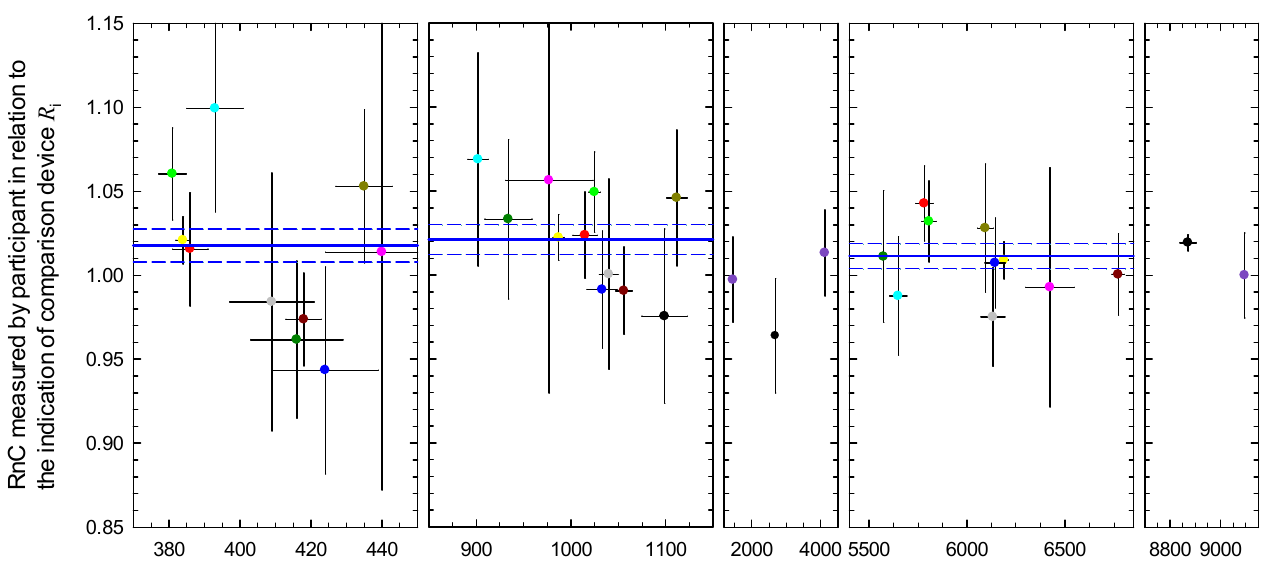
Figure 1. Ratio 𝑅 (cid:3036) of the mean radon activity concentration (RnC) that was determined by each participant to that of the comparison device given for the different exposures; error bars indicate the standard uncertainties of the reported values, results of the same participant are indicated by the same color, blue straight lines indicate the uncertainty-weighted average ratio 𝑅 (cid:2933) and dashed blue lines cover the range of the standard uncertainty.